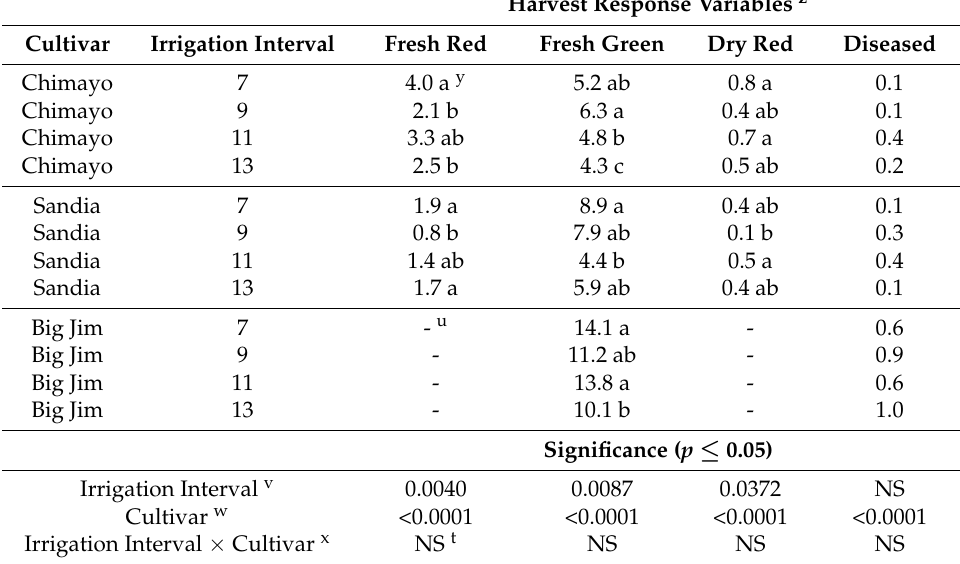
Table 3. Main effects and interactions of three cultivars and four irrigation intervals on yield components, 2011.